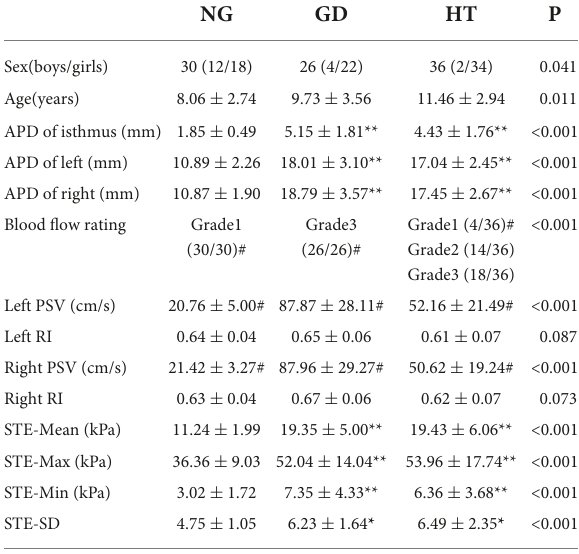
TABLE 1 Routine ultrasound and elastic results in studied